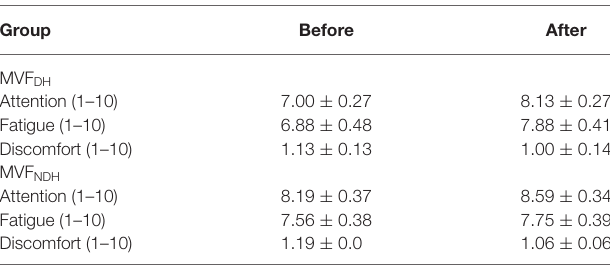
Frontiers in Human Neuroscience |